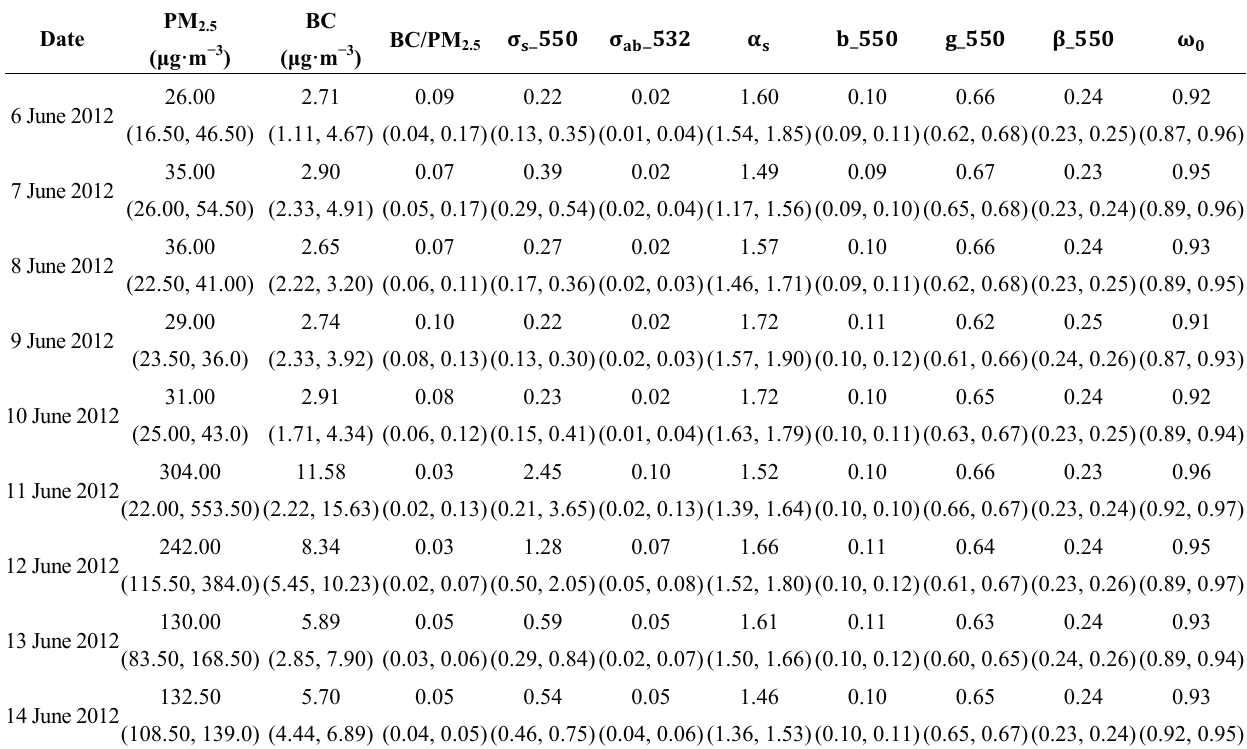
Median values are stated on the top line and the 10th and 90th percentiles are stated underneath within the